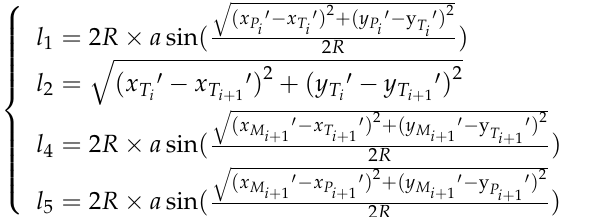
D is less than the minimum is less than the minimum i (cid:48) P i + 1 + ′ 1 i i O P ∠ ≤ , ( b ) is the sche- 90 OPP + 1 i i i ∠ > , the red line is the calculated shortest route. 90 OPP + 1 i i i